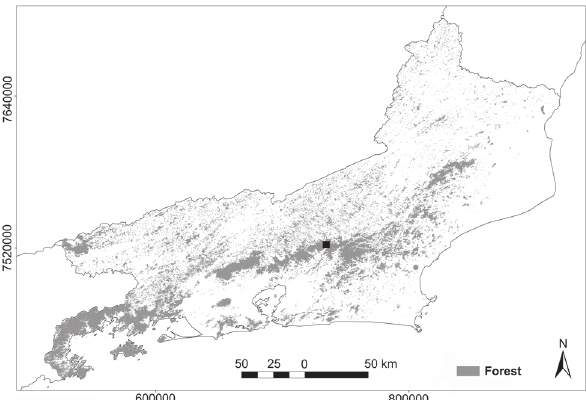
Figure 1. Location of Reserva Ecológica de Guapiaçu (REGUA, black square) in the state of Rio de Janeiro.